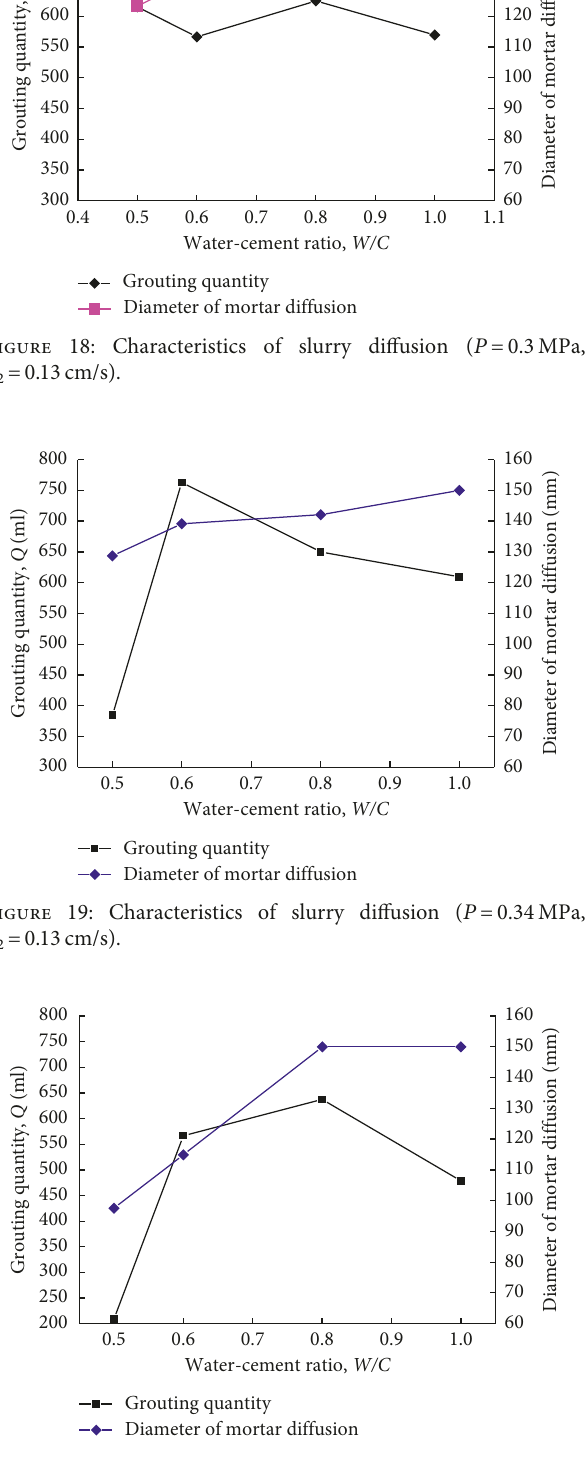
Figure 17: Characteristics of slurry diffusion ( P � 0.2 MPa, k 2 � 0.13cm/s).